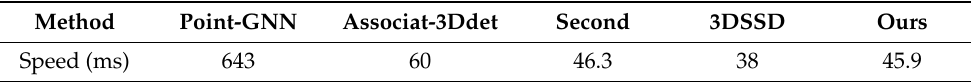
Table 7. AP of different keypoint